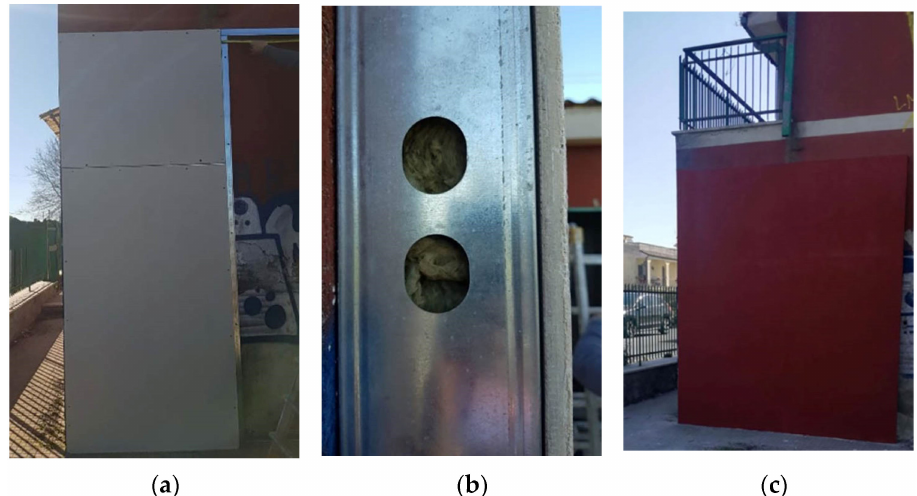
Figure 9. Implementation of energy efficiency solution: ( a ) anchor, panel and joint installation; ( b ) panel section; ( c ) installation completed.